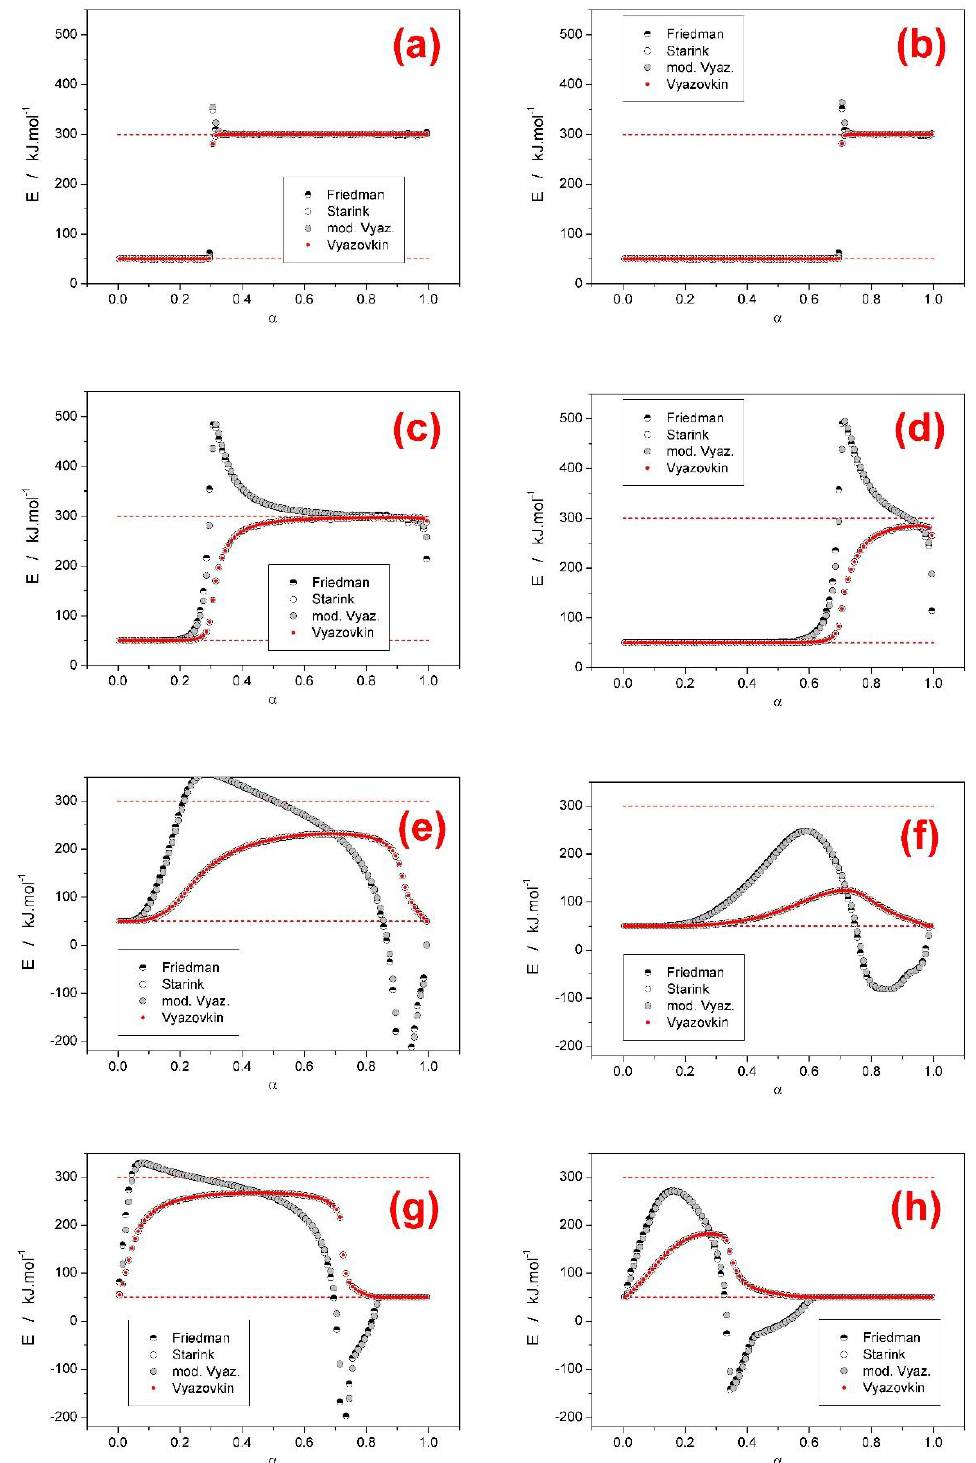
Figure 7. Results of the Friedman, Starink, Vyazovkin, and modified incremental Vyazovkin analyses applied to the datasets A–D (group 2) and the I 1 = 0.30, I 2 = 0.70, and I 1 = 0.70, I 2 = 0.30 simulated at 10,000 points / curve density. The horizontal red dashed lines in each graph represent the true E 1 and E 2 values input into the simulations. ( a ) set A, I 1 = 0.30, I 2 = 0.70; ( b ) set A, I 1 = 0.70, I 2 = 0.30; ( c ) set B, I 1 = 0.30, I 2 = 0.70; ( d ) set B, I 1 = 0.70, I 2 = 0.30; ( e ) set C, I 1 = 0.30, I 2 = 0.70; ( f ) set C, I 1 = 0.70, I 2 = 0.30; ( g ) set D, I 1 = 0.30, I 2 = 0.70; ( h ) set D, I 1 = 0.70, I 2 = 0.30.